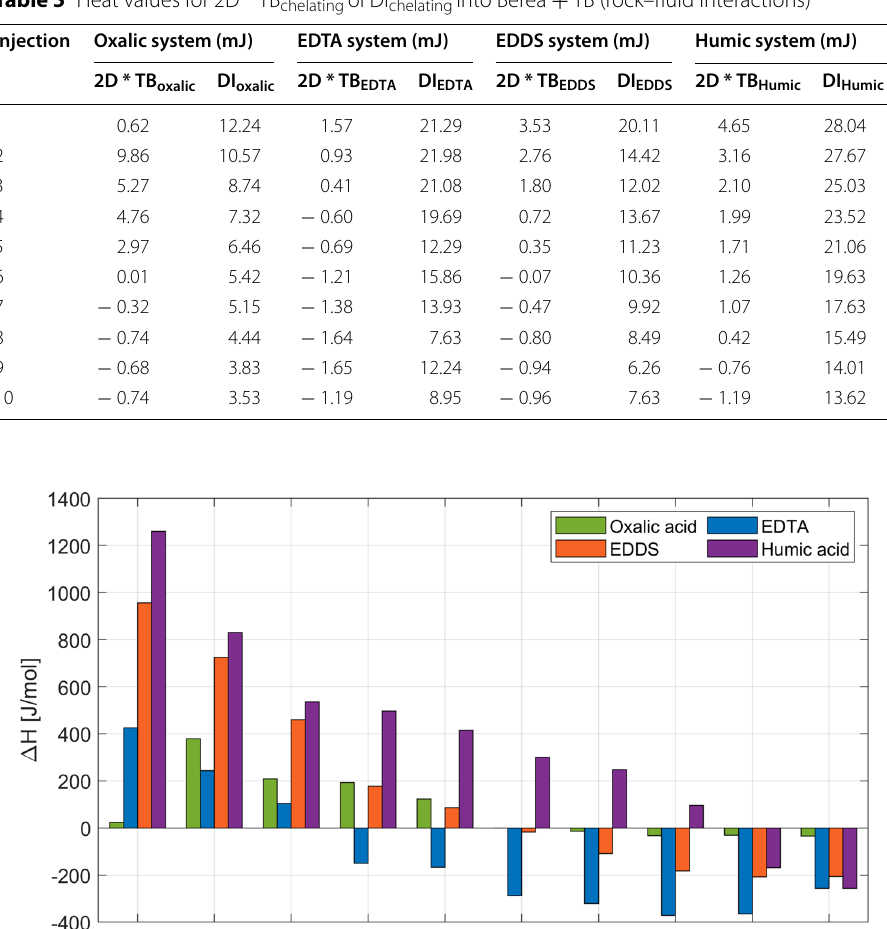
Table 5 Heat values for 2D * TB chelating or DI chelating into Berea injection Oxalic system (mJ)